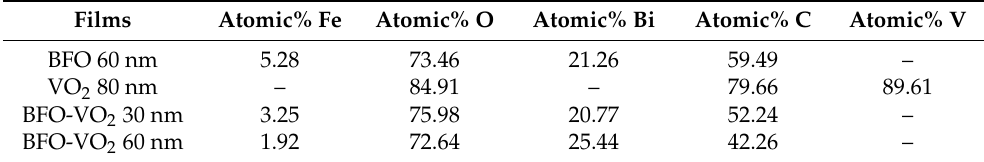
Figure 13. Atomic percentages on the surface of the selected films. Table 1. Summary of atomic percentages on the surface of the thin films